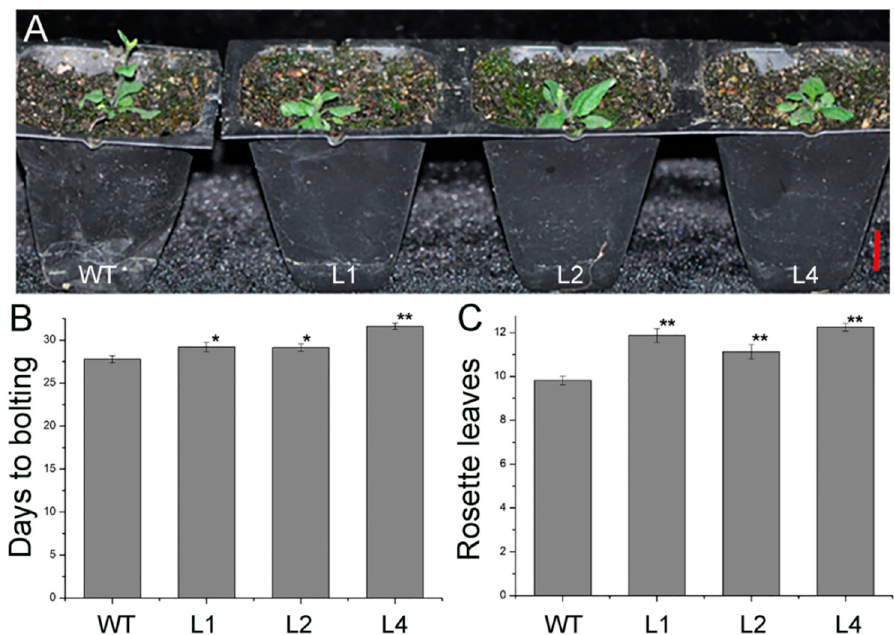
Figure 4. Ectopic expression of JcTPPJ causes late flowering in transgenic Arabidopsis . ( A ) Wild-type (WT) and transgenic Arabidopsis lines (L1, L2, and L4) grown under long-day conditions (16 h light / 8 h dark) after vernalization, the bar represent 1.0 cm. Days ( B ) and rosette leaves ( C ) after the main inflorescence shoot had elongated past 1 cm in 35S:JcTPPJ transgenic Arabidopsis lines grown under long-day conditions. * indicates a significant di ff erence at the p < 0.05; ** indicates a significant di ff erence at the p < 0.01 level determined by one-way ANOVA. The error bars represent the standard errors ( n = 16).